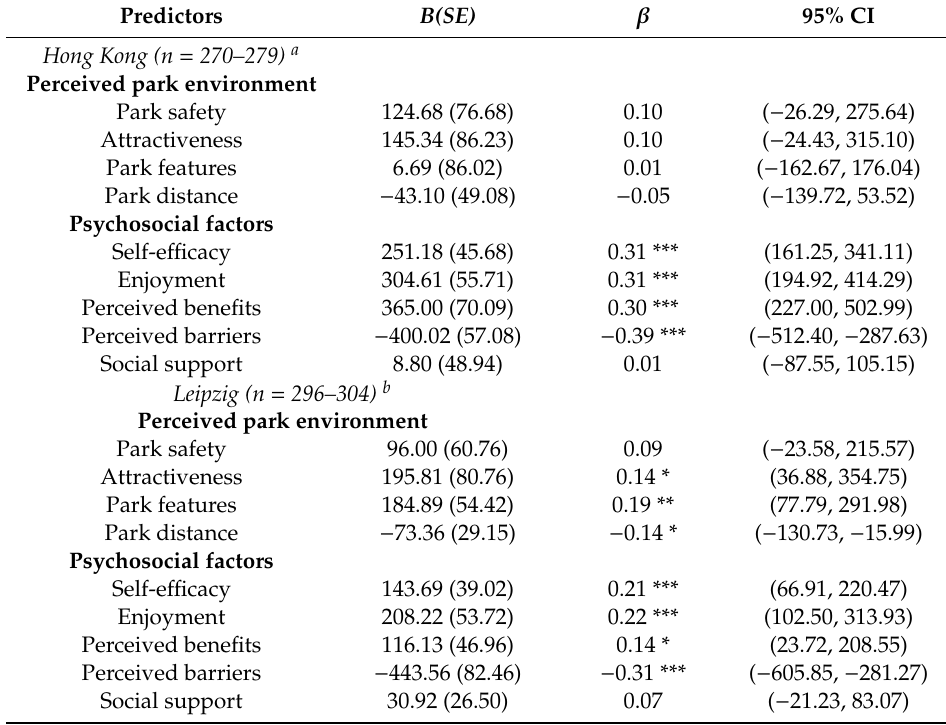
Table 3. Results of the associations between park-based physical activity and each of the perceived park environmental and psychosocial factors in older adults from Hong Kong and